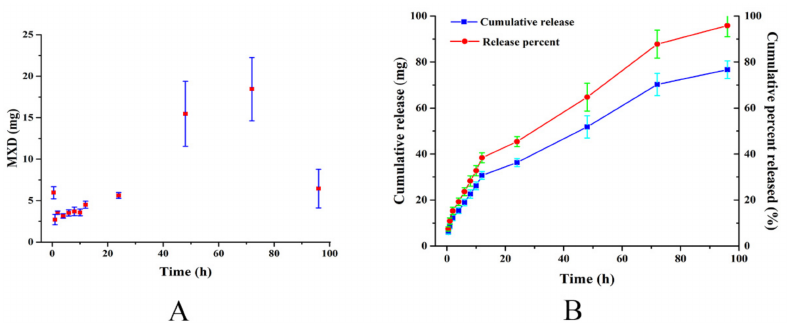
Figure 1. In vitro release of MXD-TG. ( A ) The release amount of MXD at different times; ( B ) the cumulative release and cumulative percent released of MXD.